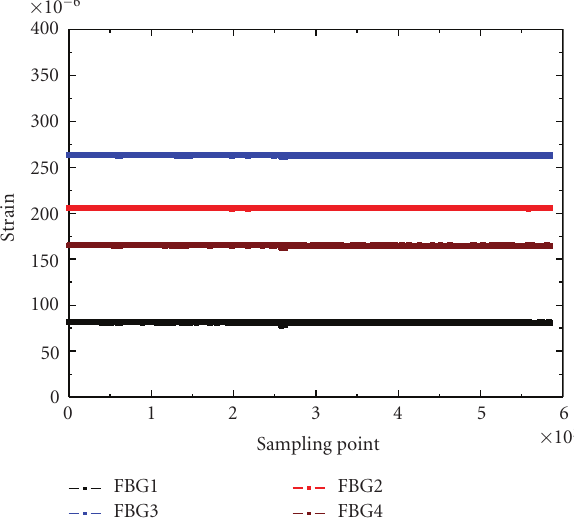
Figure 11: Strain data recorded in one